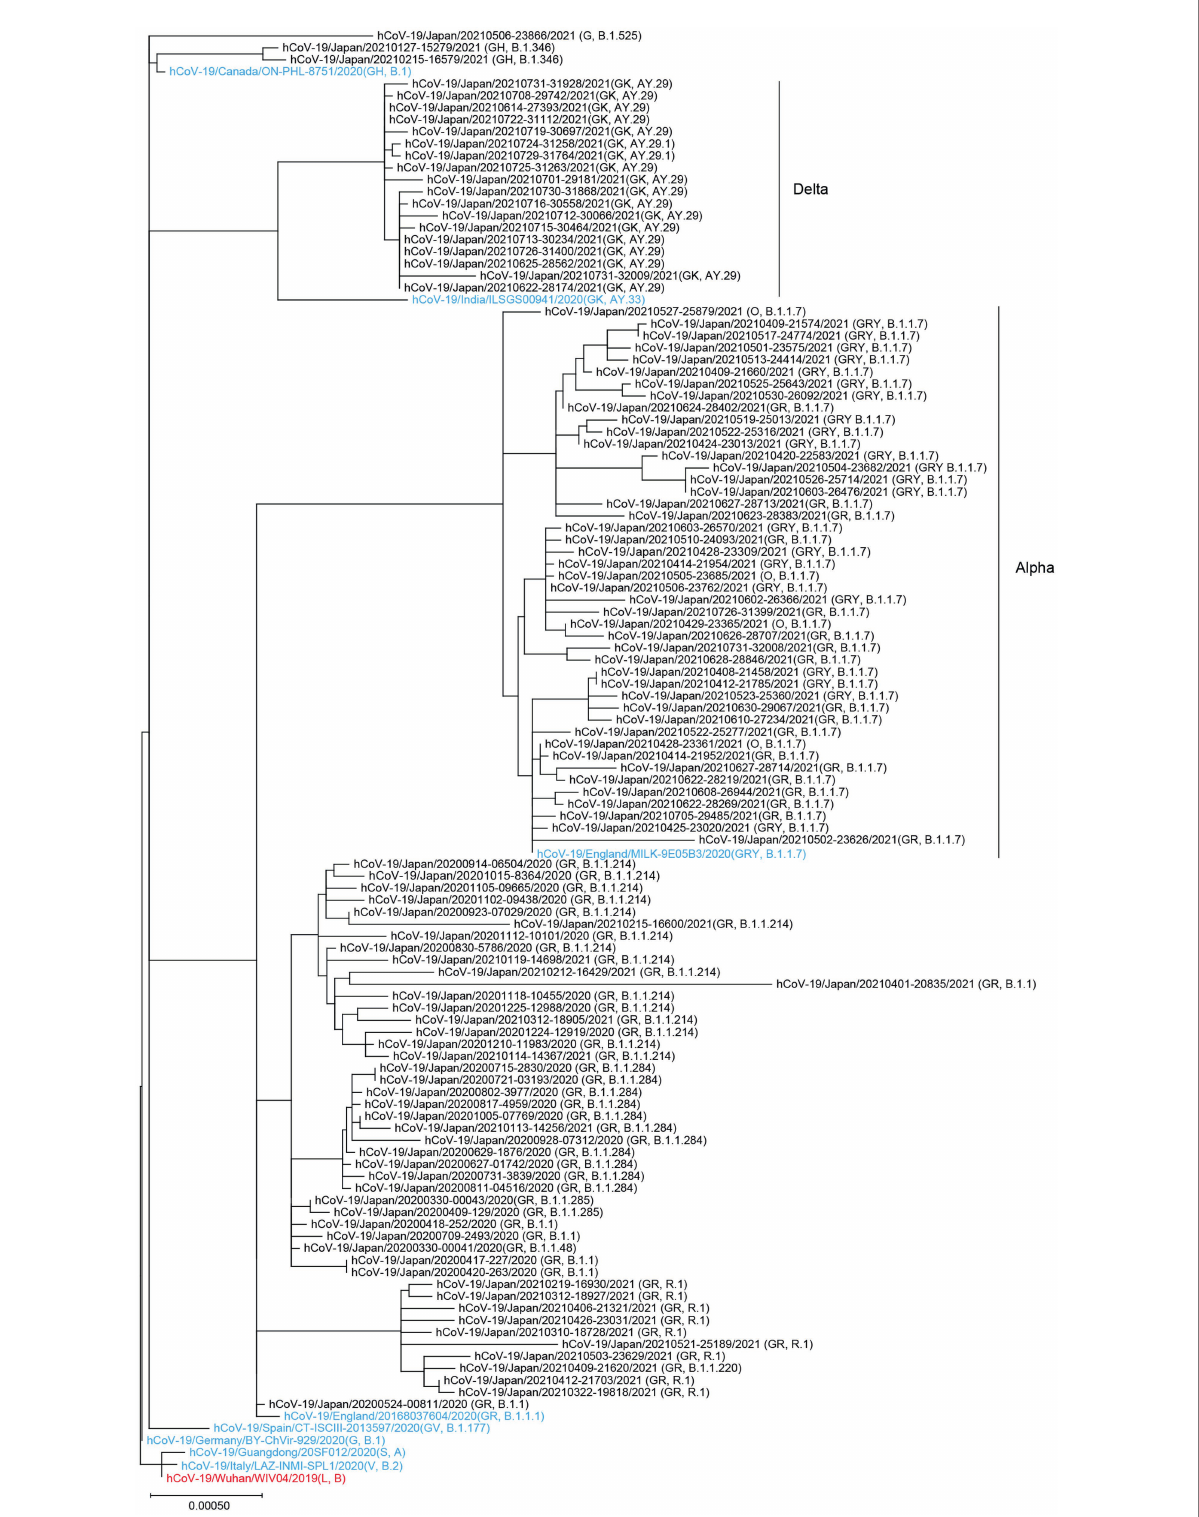
FIGURE 2 Phylogenetic tree of the SARS-CoV-2 genomes collected at Juntendo University Hospital. This tree includes 112 genomes from Juntendo University Hospital and nine reference sequences. The reference strain hCoV-19/Wuhan/WIV04/2019 is shown in red and the other references are shown in